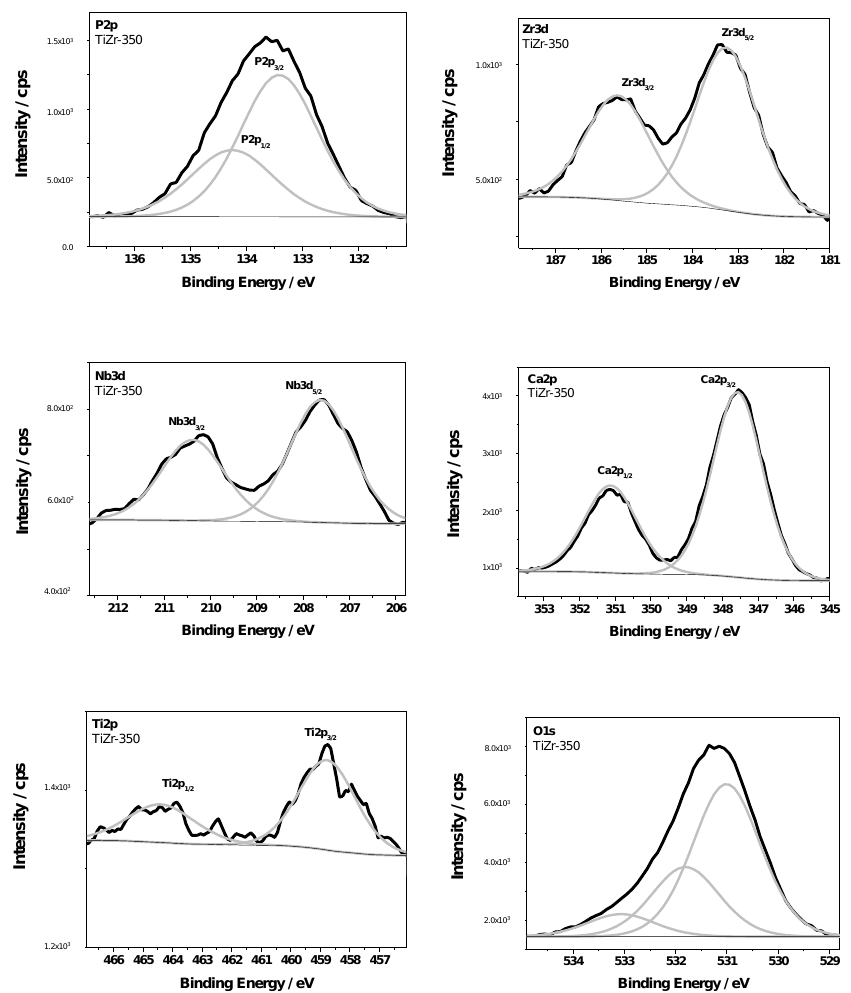
Figure 5. The high resolution XPS spectra after the deconvolution procedure, sample TiZr-350.